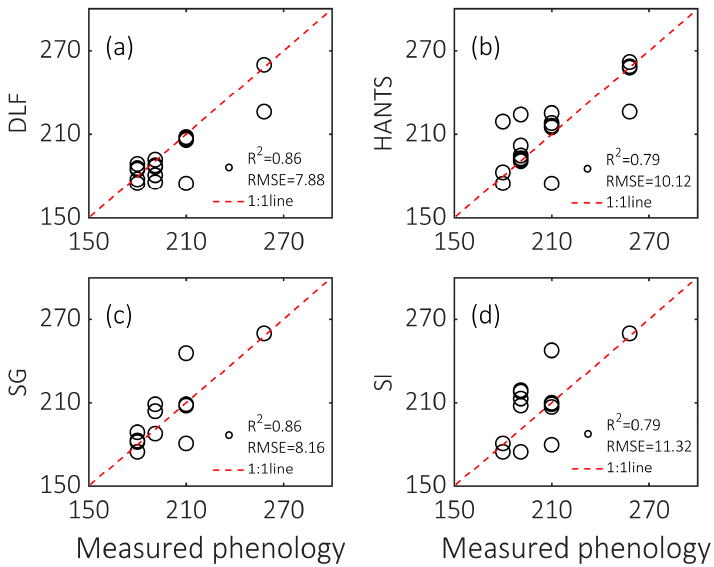
Figure A2. Comparison of extracted and observed phenology from ground observations of maize using different filtering methods at the site in Shangqiu in 2019. Note: ( a – d ) represented the comparison of extracted phenology using DLF, HANTS, SG, and SI, respectively.